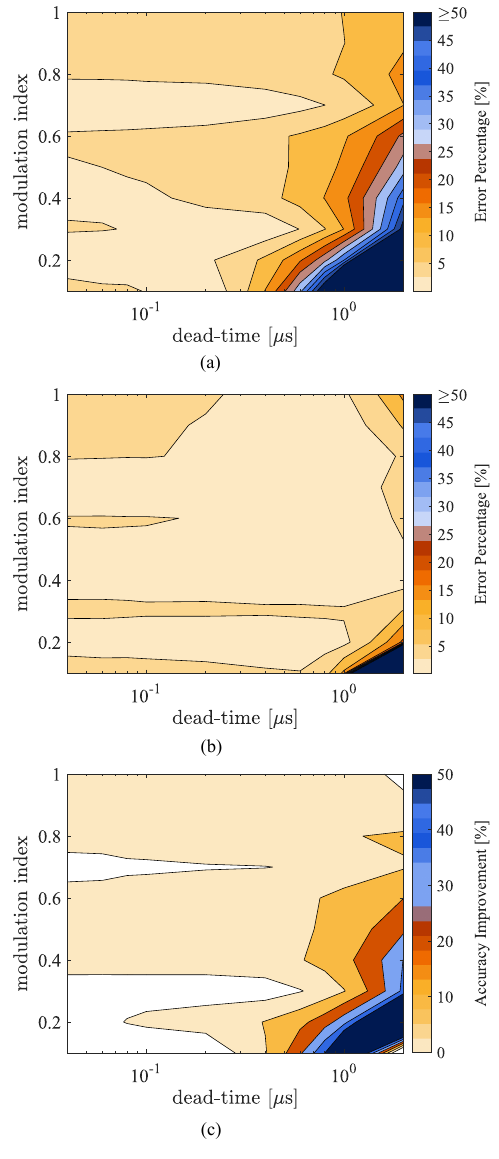
Figure 19. Absolute error percentage of the ( a ) benchmark and ( b ) proposed equations; ( c ) relative improvement of the proposed equations compared to the benchmark equations (case 2 load,